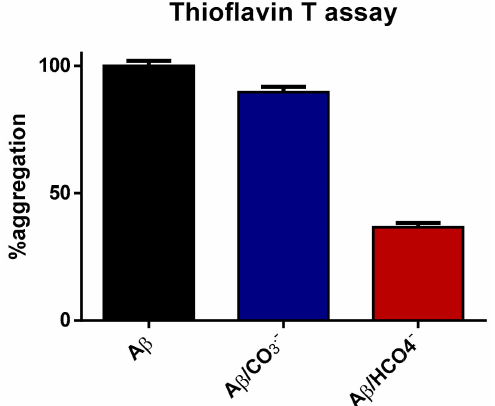
Figure 9. Thioflavin-T fluorimetric aggregation assay of A β 25-35 in the presence or absence of HCO 4 −